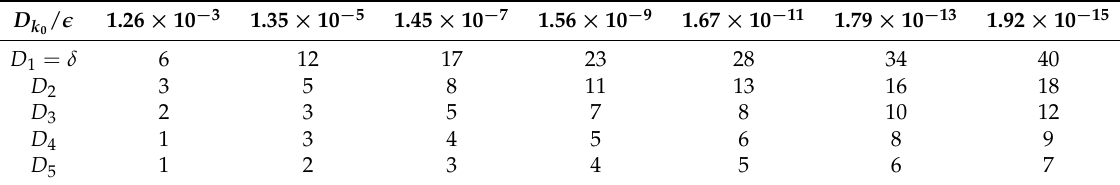
Table 4. Subdivision depth of 4-point approximating ternary subdivision